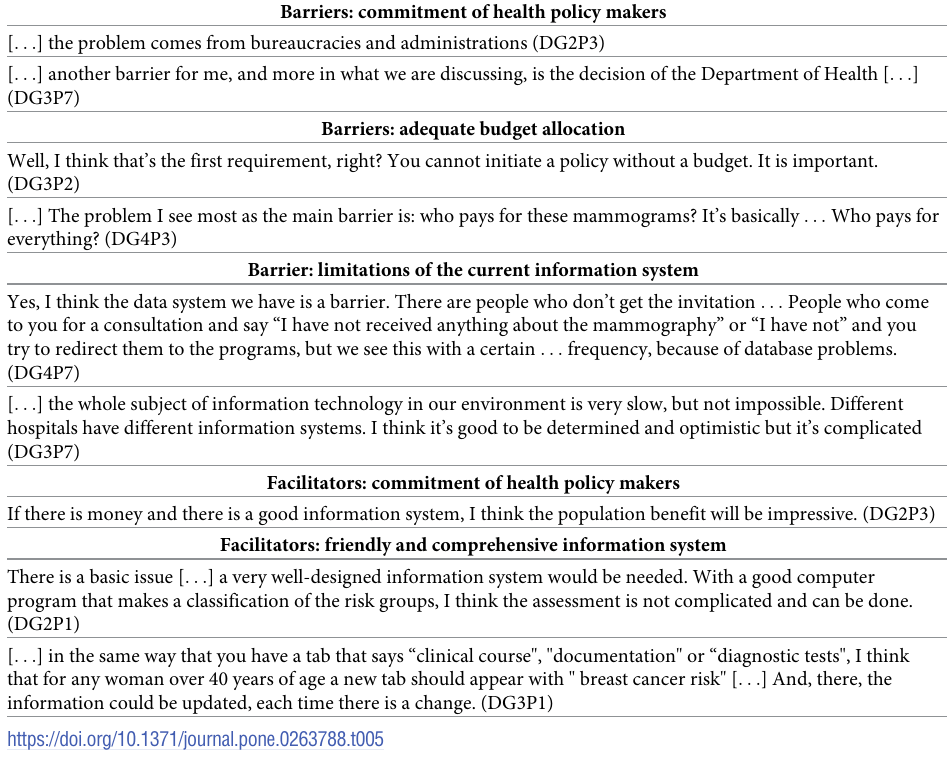
Table 5. Selected quotes from health professionals’ discussion groups on health system barriers and